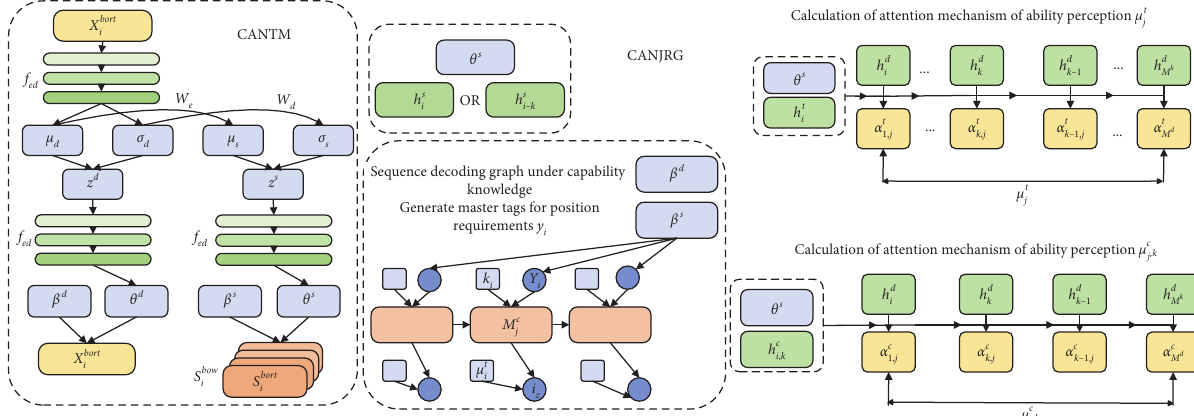
Figure 1: Schematic diagram of the framework of this paper (without CAPGTA).